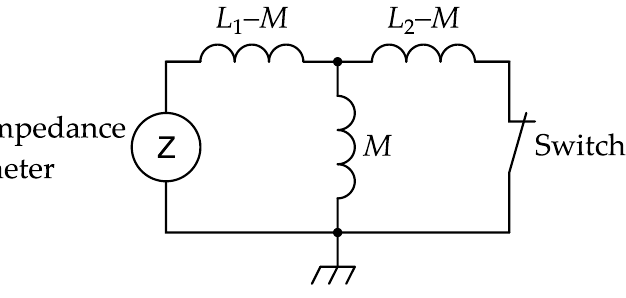
Figure 9. Circuit diagram of T-shape equivalent transformer for measurement of inductances.